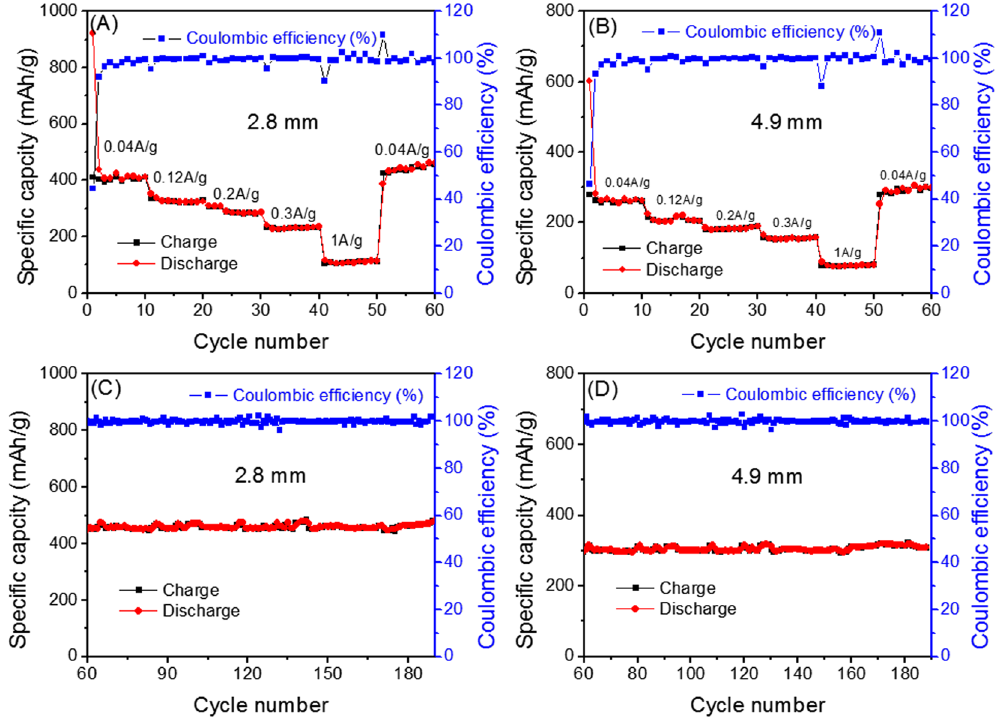
Figure 6. Rate capability of the ECF with a thickness of 2.8 mm ( A ) and 4.9 mm ( B ) varying current densities from 0.04 to 1 A/g; Subsequent cycling tests of the ECF electrodes with thickness of 2.8 mm ( C ) and 4.9 mm ( D ) at 0.04 A/g from 60 th to 190 th